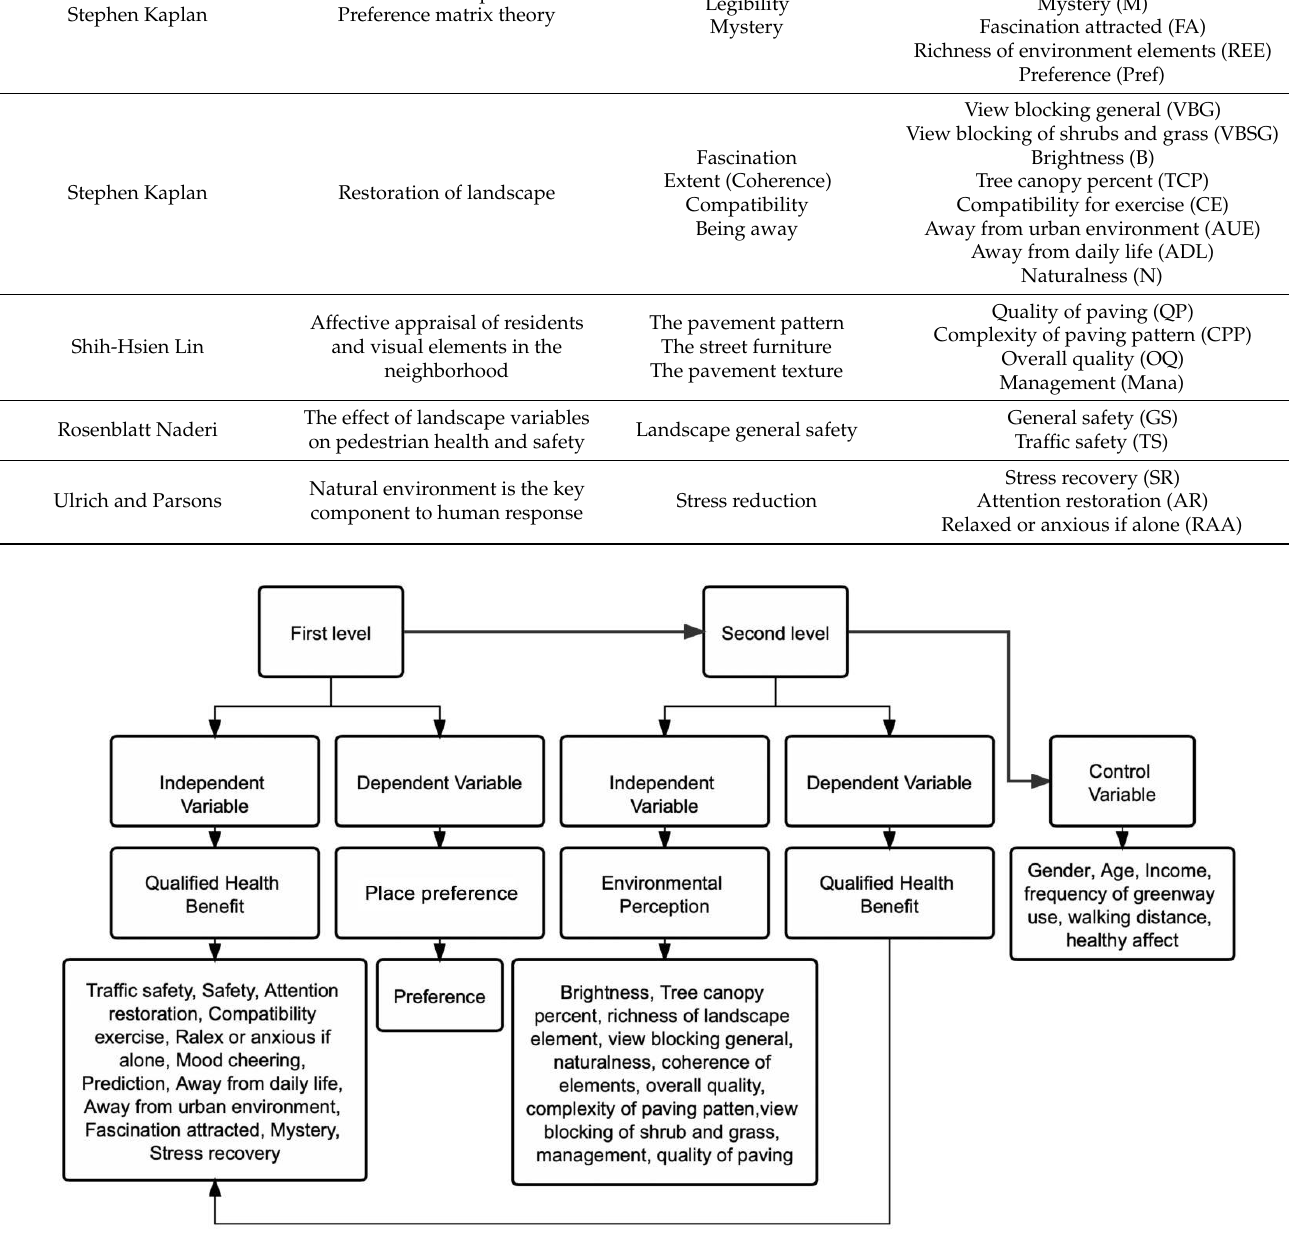
Figure 3. The multilevel mapping model.